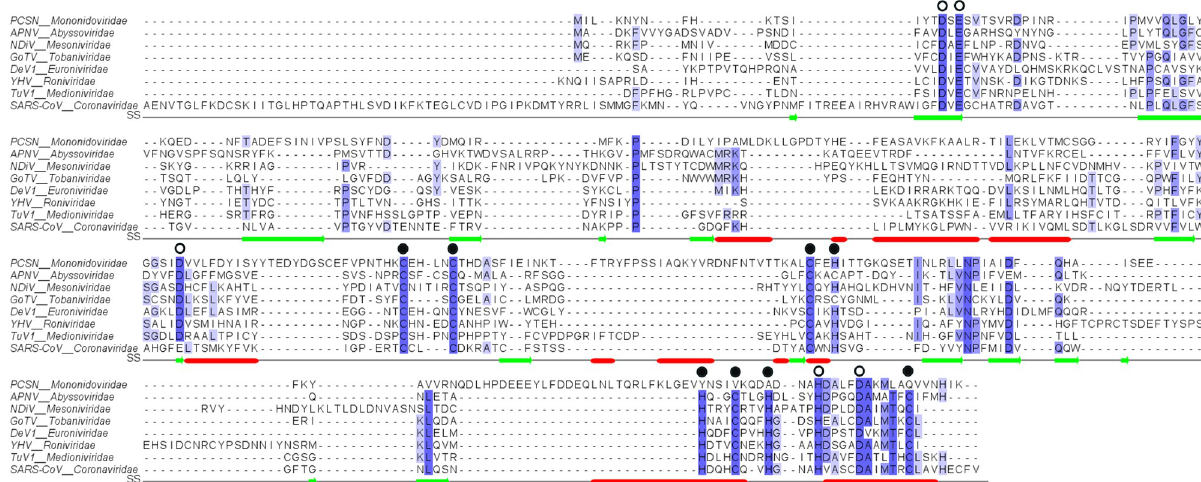
Fig 2. Multiple sequence alignment of the nidovirus ExoN domain. The Exo I (DE), Exo II (D/E), and Exo III (Dh) conserved sequence motifs are signaled with unfilled circles above them. Zinc binding motif 1 (ZF1, CCCH/C) and zinc-binding motif 2 (ZF2, HCHC) are signaled with filled circles above them. Secondary structure is indicated as red, helix; green, beta strand. Viral sequences abbreviation: PCSN, Planarian cell-secretory nidovirus; APNV, Aplysia californica nidovirus; NDiV, Nam Dinh virus; GoTV, Goat torovirus; DeV1, Decronivirus 1; YHV, Yellow head virus; and TuV1, Turrinivirus 1.